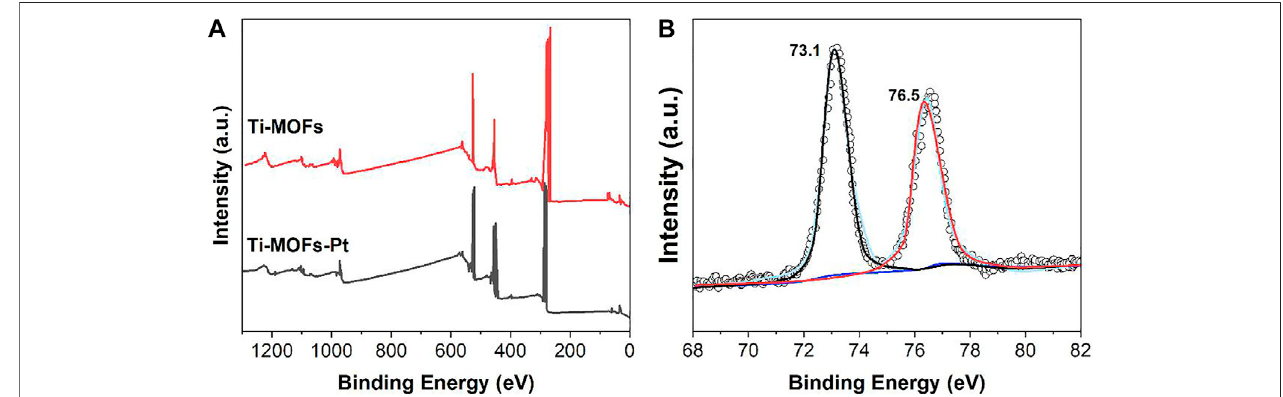
FIGURE 3 | (A) TEM and (B) HRTEM images of Ti-MOFs-Pt. (C – H) C, N, O, Ti, and Pt mapping of Ti-MOFs-Pt.